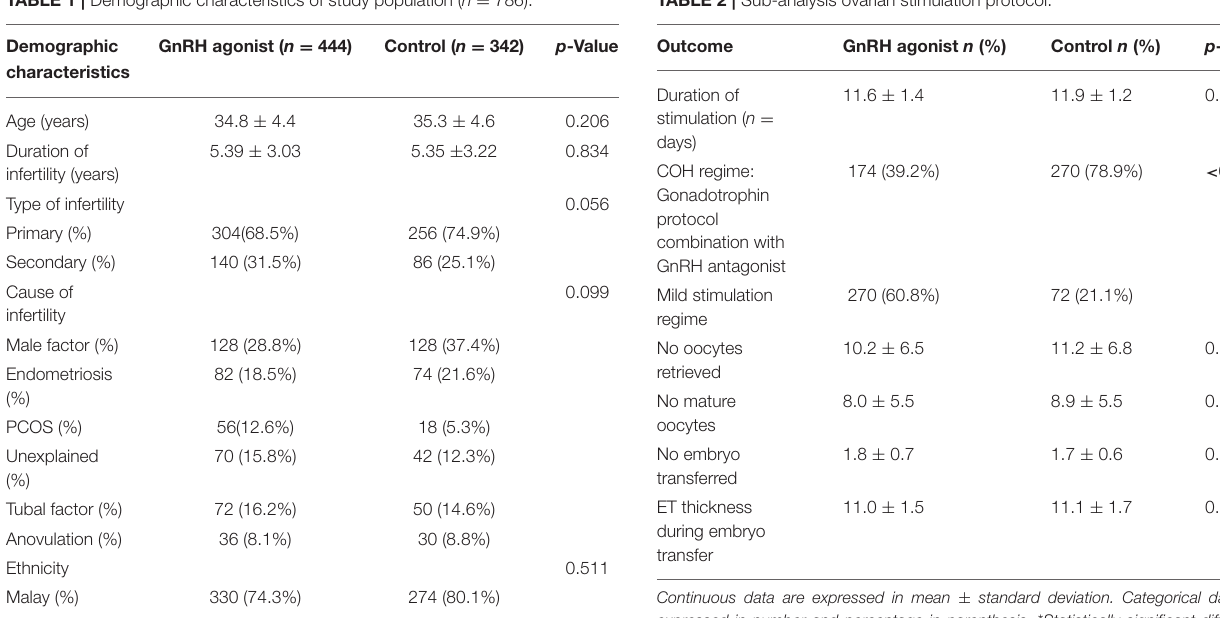
TABLE 1 | Demographic characteristics of study population ( n = 786). TABLE 2 | Sub-analysis ovarian stimulation protocol.